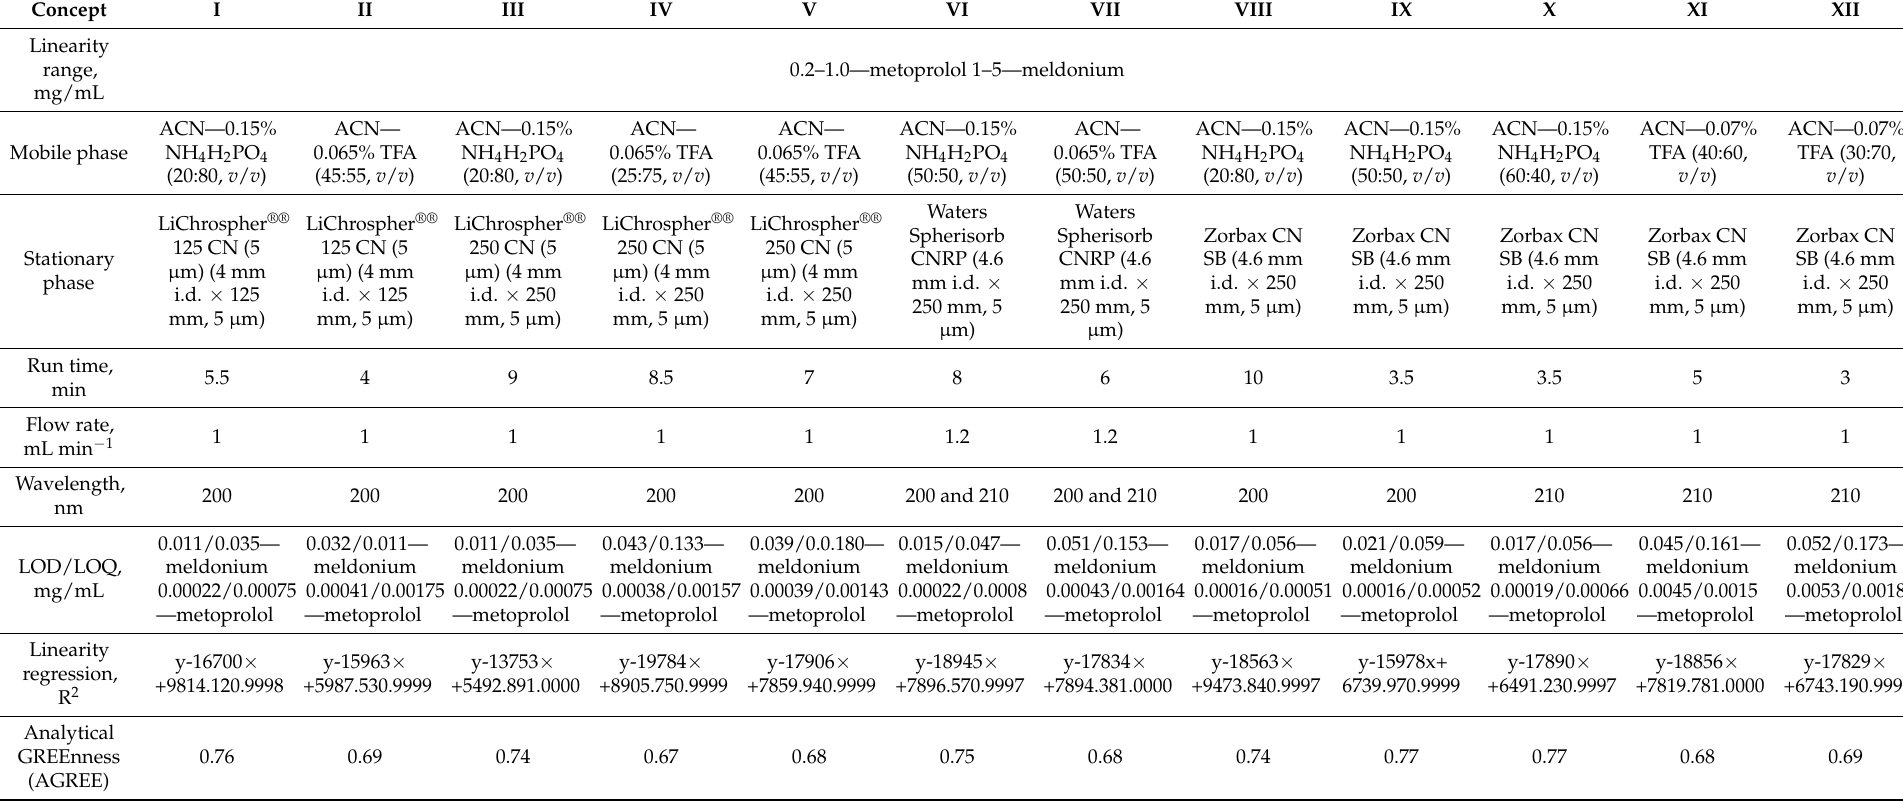
Table 1. Comparison between the proposed HPLC